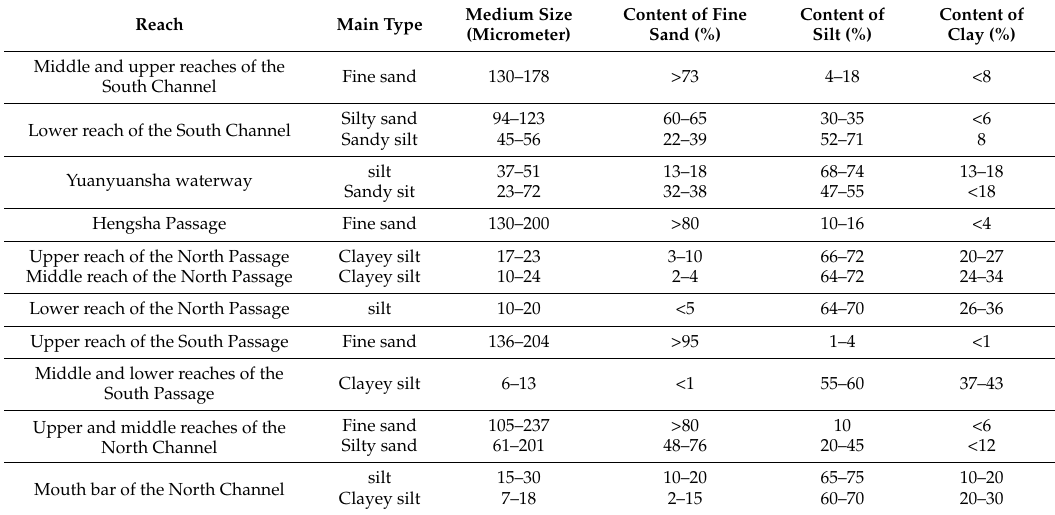
Table 2. Types and grain size distribution of sea-bottom sediment in the Yangtze estuary.